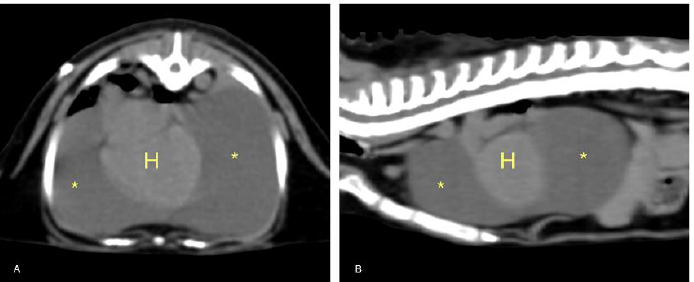
Figure 5. Transverse ( A ) and sagittal ( B ) TC sections of the thorax. Severe pericardial effusion (asterisks) with mild right dorsal-lateral heart (H) displacement.